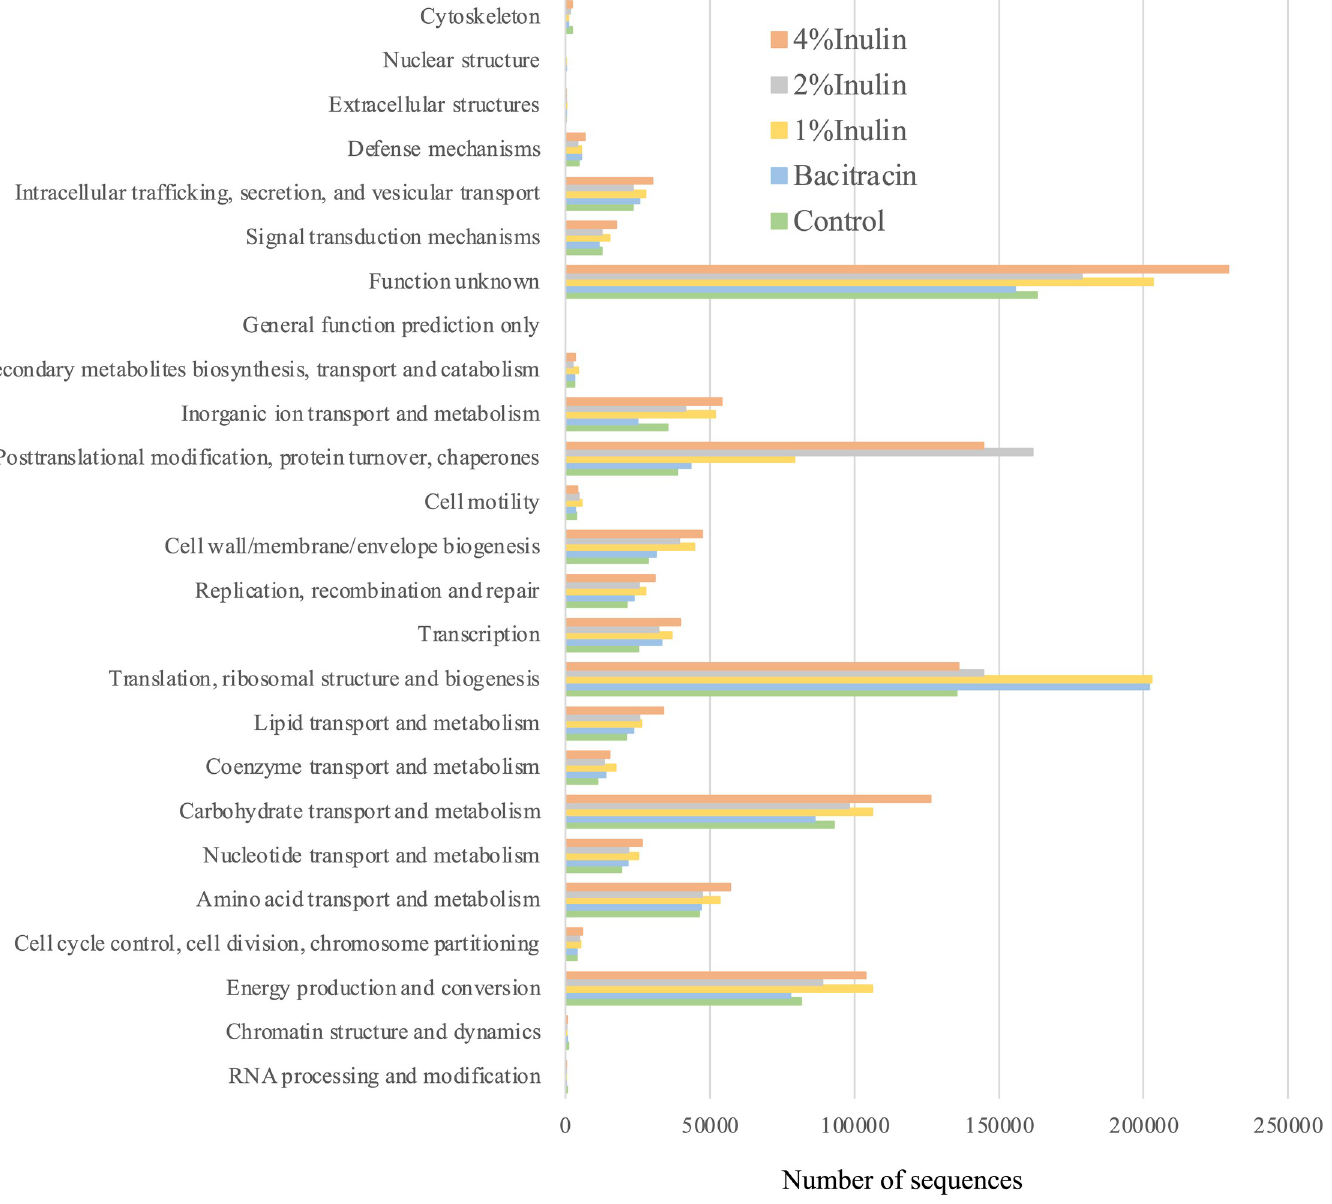
Fig 3. Expression numbers of functional genes based on cluster of orthologous groups of proteins identified in the cecal microbiota of broilers fed a basal diet supplemented with 0 (control), 1%, 2% or 4% inulin or 400 ppm bacitracin.